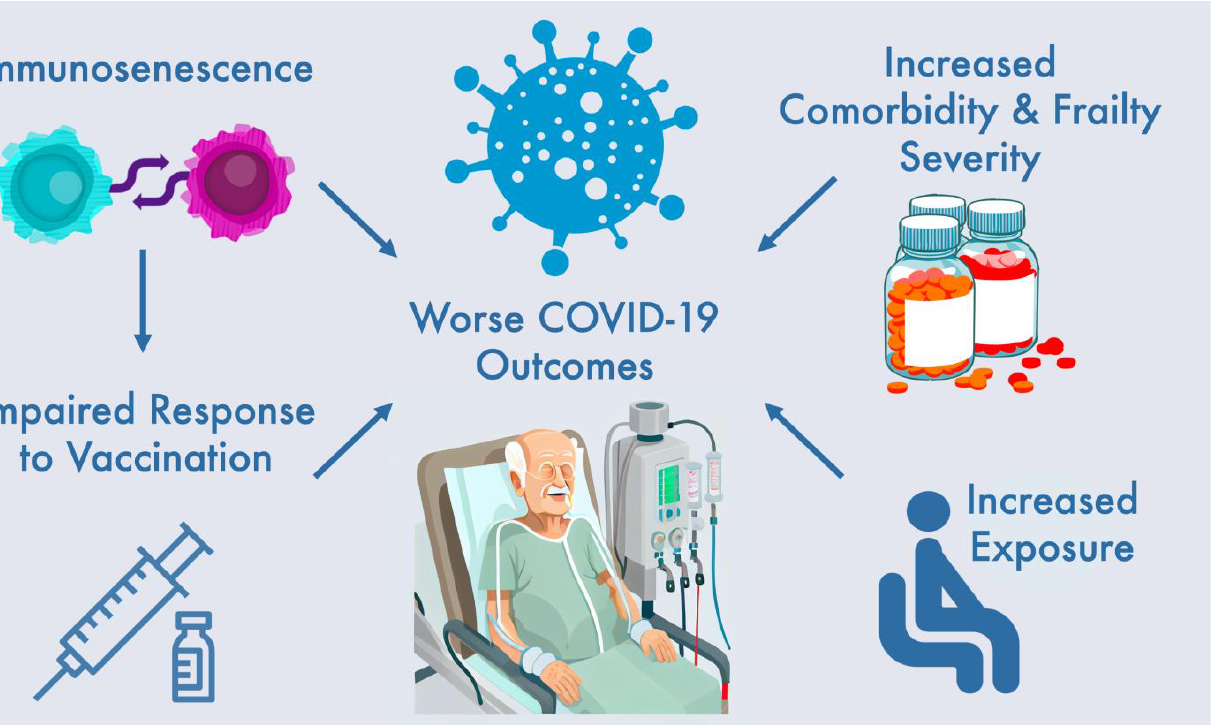
Figure 1. Risk factors for worsened clinical outcomes in elderly haemodialysis patients with COVID-19.